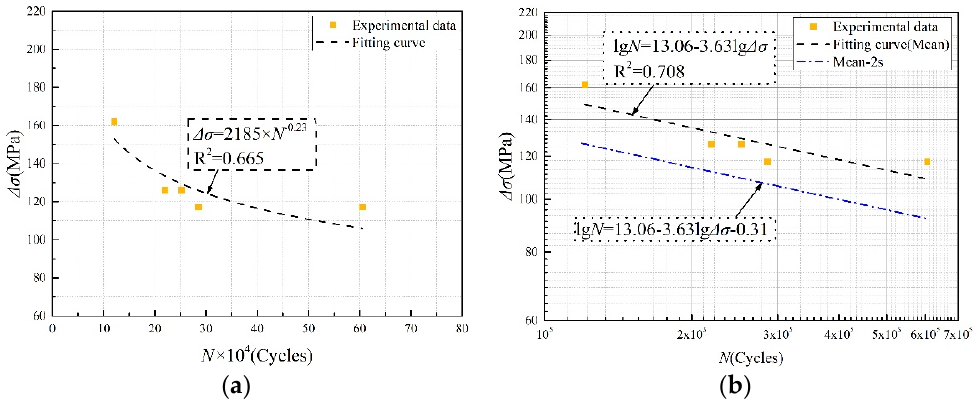
Figure 16. S-N curve of failure mode 3. ( a ) Power ( b ) Double logarithmic.